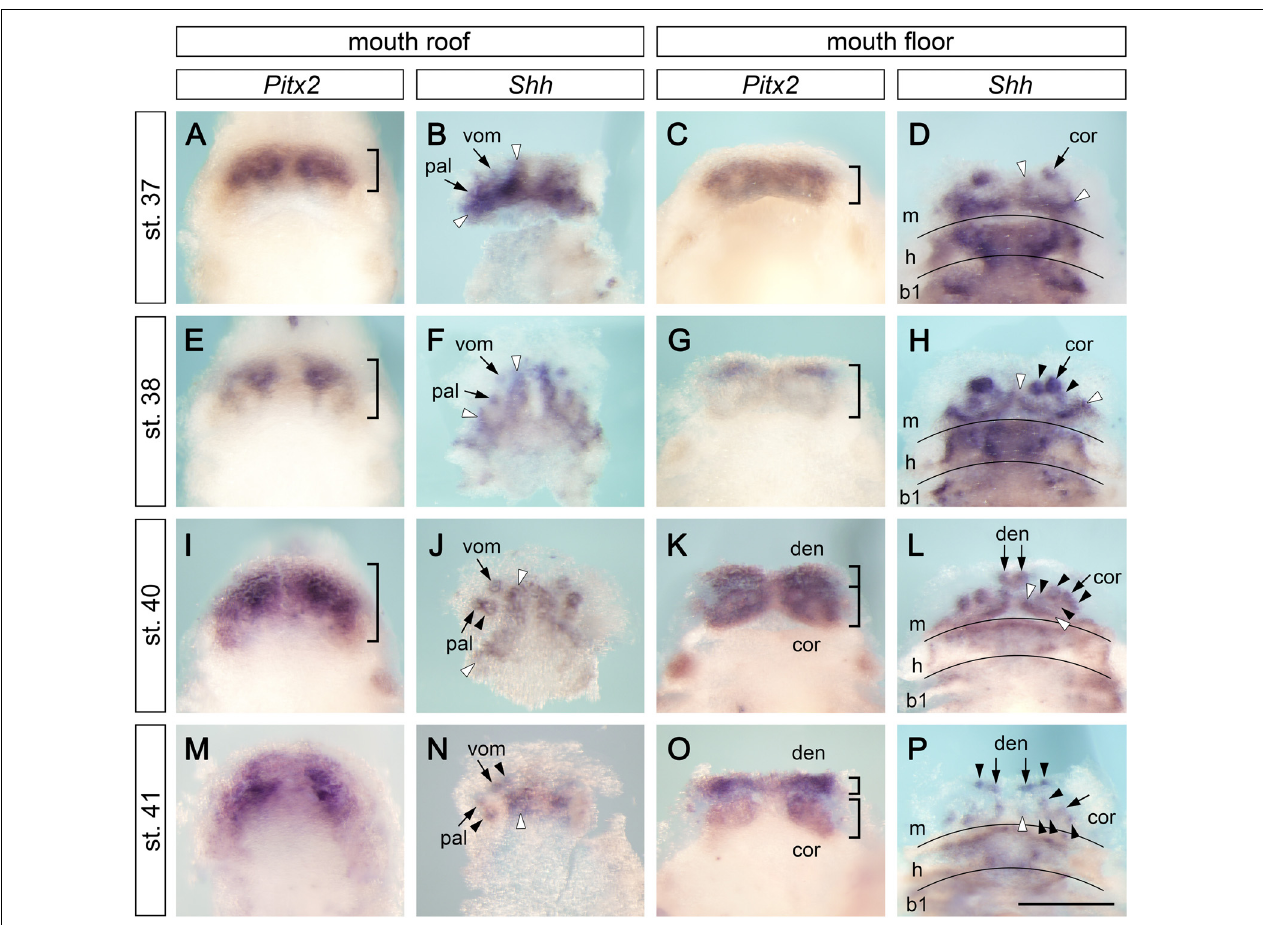
FIGURE 2 | Expression patterns of Pitx2 and Shh at early stages of axolotl odontogenesis. Expression patterns of early odontogenic markers Pitx2 and Shh on the mouth roof and floor whole mounts show initial stages of development of axolotl dentition (in case of Shh expression, the epithelium of the mouth roof was dissected from whole mounts to circumvent masking of the tooth-restricted epithelial signal by the strong Shh signal from the adjacent neural tube). At stages 37–41, Pitx2 labels tooth-competent regions while Shh is restricted to individual tooth germs and into postero-medially placed odontogenic bands (visualized as strands of Shh expression demarcated by white arrowheads). Positions of tooth germs are visible as regions of lower Pitx2 expression. (A,E,I,M) Expression pattern of Pitx2 on the mouth roof is initially restricted to its anterior part but becomes broader at later stages (parentheses). (B,F,J,K) Focal expression of Shh illustrates sequential addition of tooth germs starting from the initiator-teeth of vomerine (vom) and palatine (pal) teeth ( B,F , arrows). New tooth germs are added postero-medially in the palatine tooth field ( J , black arrowheads) and antero-medially in the vomerine tooth field ( N , black arrowheads). (C,G,K,O) Expression pattern of Pitx2 on the mouth floor enlarges posteriorly throughout development and, at stages 40–41, the pattern separates into the prospective dentary (den) and coronoid (cor) tooth fields ( K,O , parentheses). (D,H,L,P) Focal Shh expression on the mouth floor marks positions of initiator-teeth of the coronoid ( D,H , arrows) and dentary fields ( L,P , arrows) and the addition of new tooth germs within both tooth fields ( H,L,P , black arrowheads). New tooth germs are added lingually to the initiator tooth germ in the coronoid tooth field ( H,L,P , black arrowheads) and laterally from the medially positioned initiator tooth in the dentary tooth field ( P , arrowheads). b1, first branchial arch; cor, coronoid tooth field; den, dentary tooth field; h, hyoid arch; m, mandibular arch; pal, palatine tooth field; vom, vomerine tooth field. Scale bar equals 500 µ m.